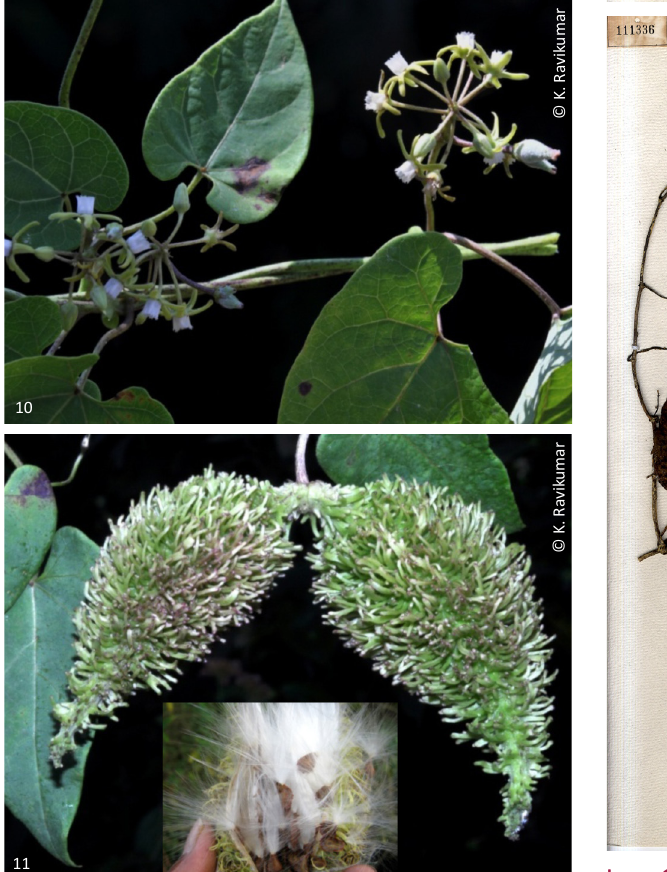
Image 12. Herbarium of Cynanchum corymbosum (a) flowers; (b)